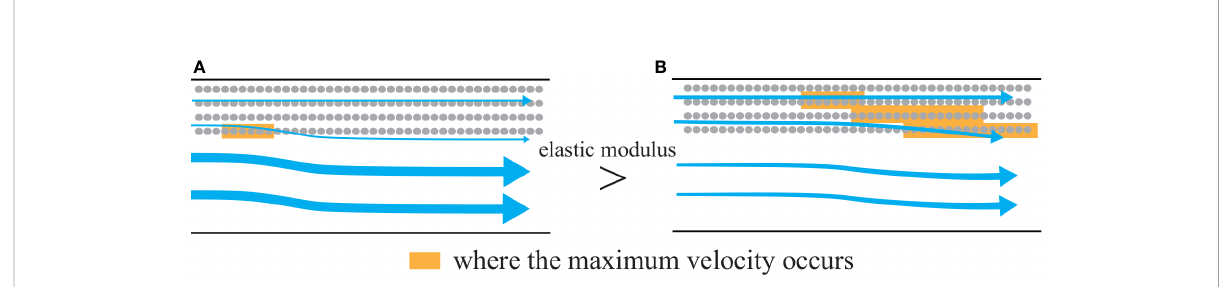
FIGURE 9 Flow modi fi cation due to an SAV patch. Arrows indicate the mean fl uxes on a horizontal plane. The elasticity is larger in case E2 than in case E2s, resulting in the larger DVH in case E2 than in case E2s. (A) Case E2, (B) case E2s.